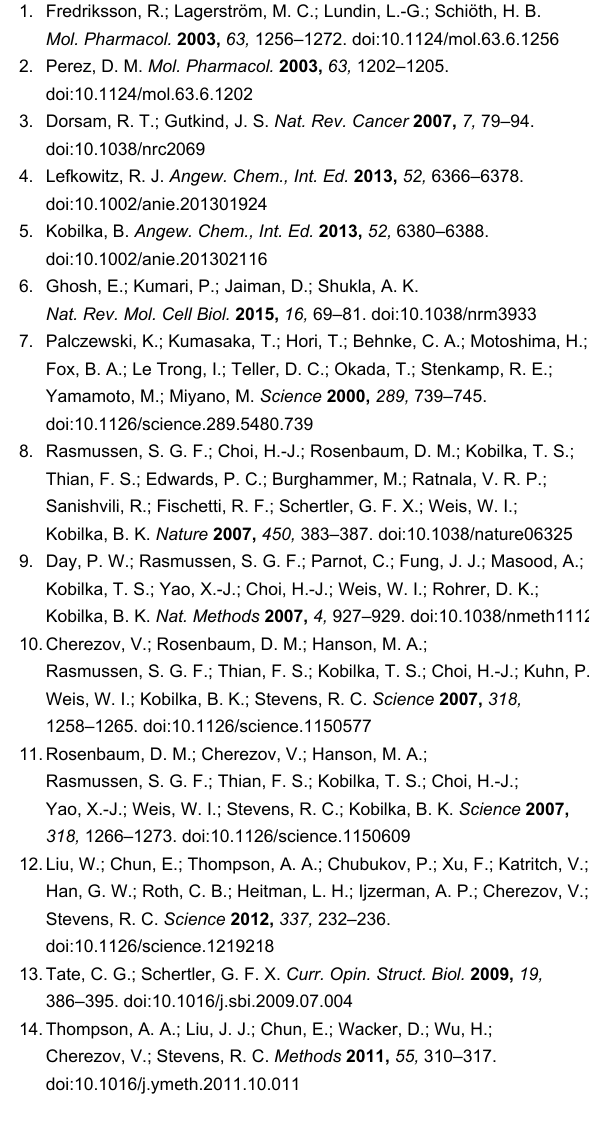
ΔΔ G (G-protein) ΔΔ G ( β -arrestin)